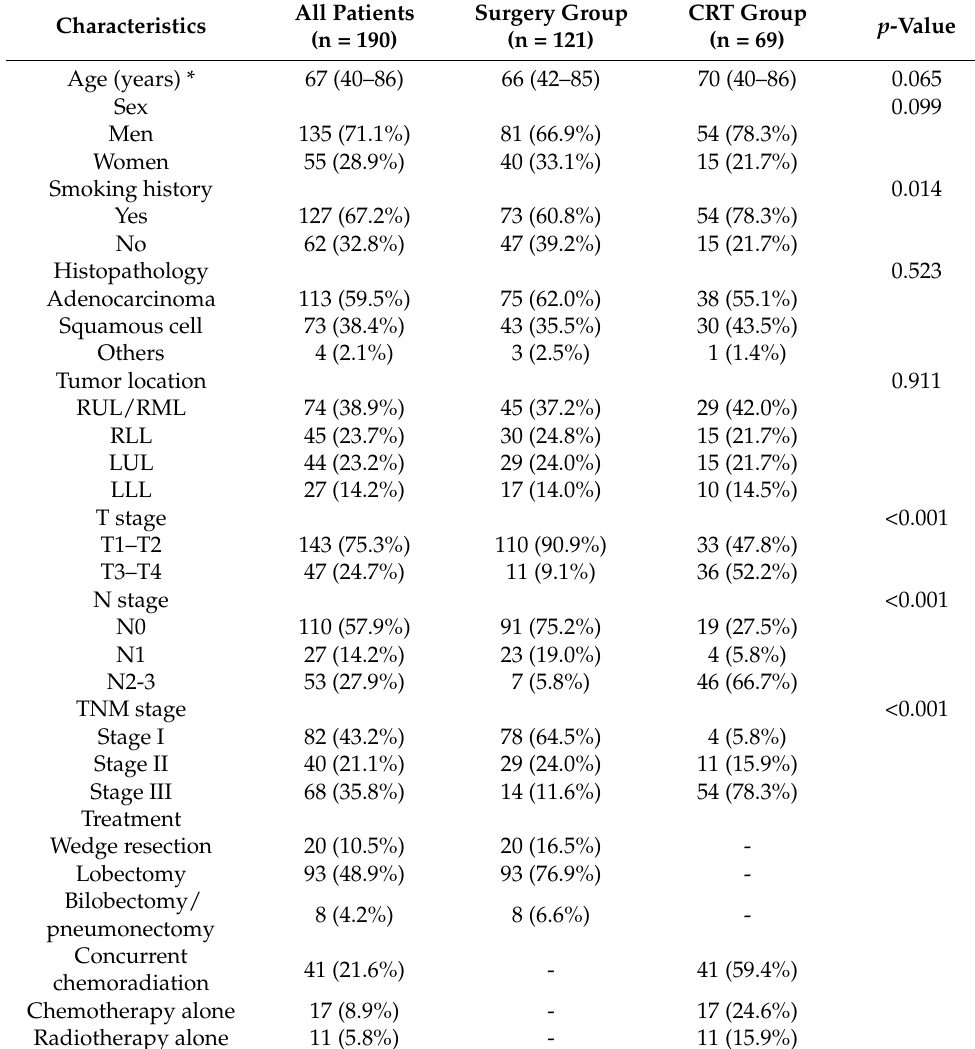
Table 1. Comparison of baseline characteristics between the surgery group (n = 121) and CRT group (n =